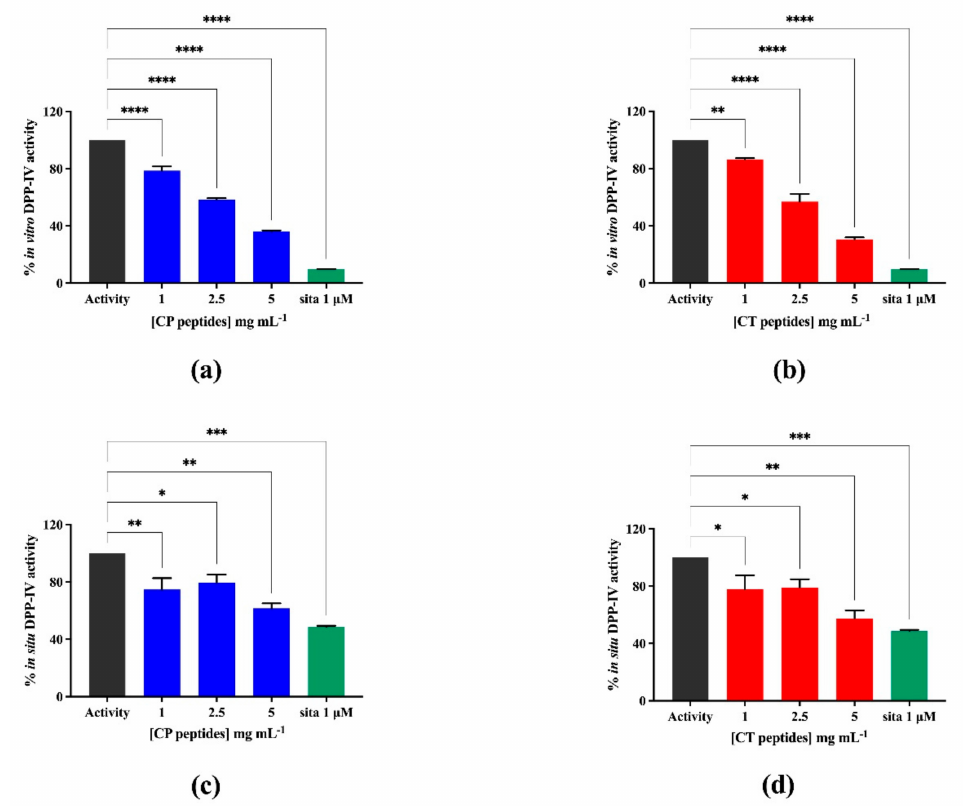
Figure 4. Evaluation of the inhibitory effects of CP and CT hydrolysates on DPP-IV. ( a , b ) in vitro activity of human recombinant DPP-IV, ( c , d ) cellular activity of DPP-IV expressed on Caco-2 cell mem- branes. Bars represent the average ± SD of 3 independent experiments in duplicates. **** p < 0.0001, *** p < 0.001, ** p < 0.01, * p < 0.05 versus untreated sample (Activity). sita: sitagliptin, positive control, at 1 µ